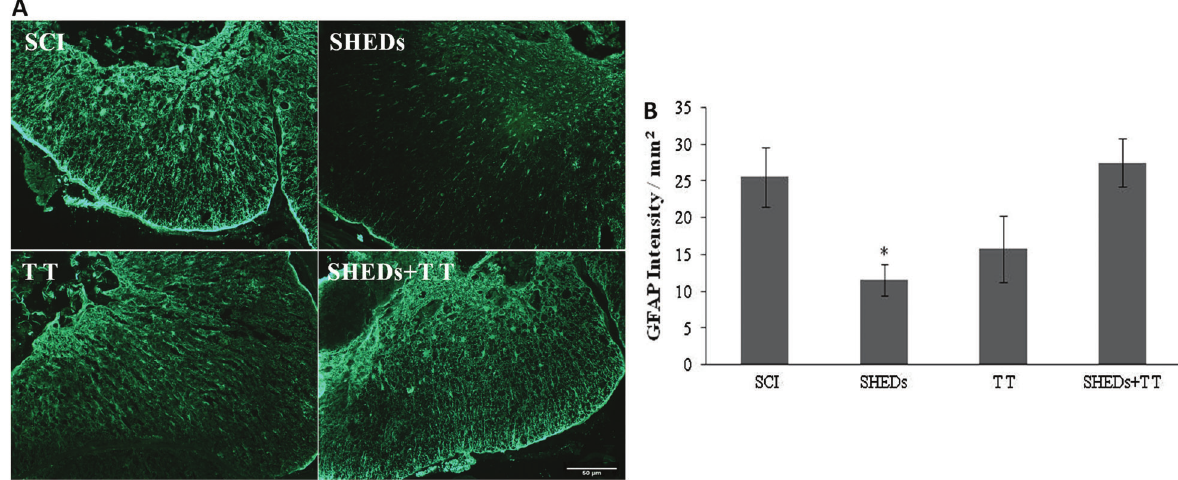
Figure 5. Representative immunostaining of GFAP expression in the epicenter of injured spinal cord, 6 weeks after spinal cord injury (SCI), SCI treated with stem cells from human exfoliated deciduous teeth (SHEDs), SCI treated with treadmill training (TT), and SCI treated with SHEDs and treadmill training (SHEDs + TT) rats ( A ). Densitometry of GFAP ( B ). Data are reported as means ± SE. *P o 0.05, SHEDs group compared to SCI group (one-way ANOVA followed by Tukey ’ s post hoc test). Scale bar = 50 m